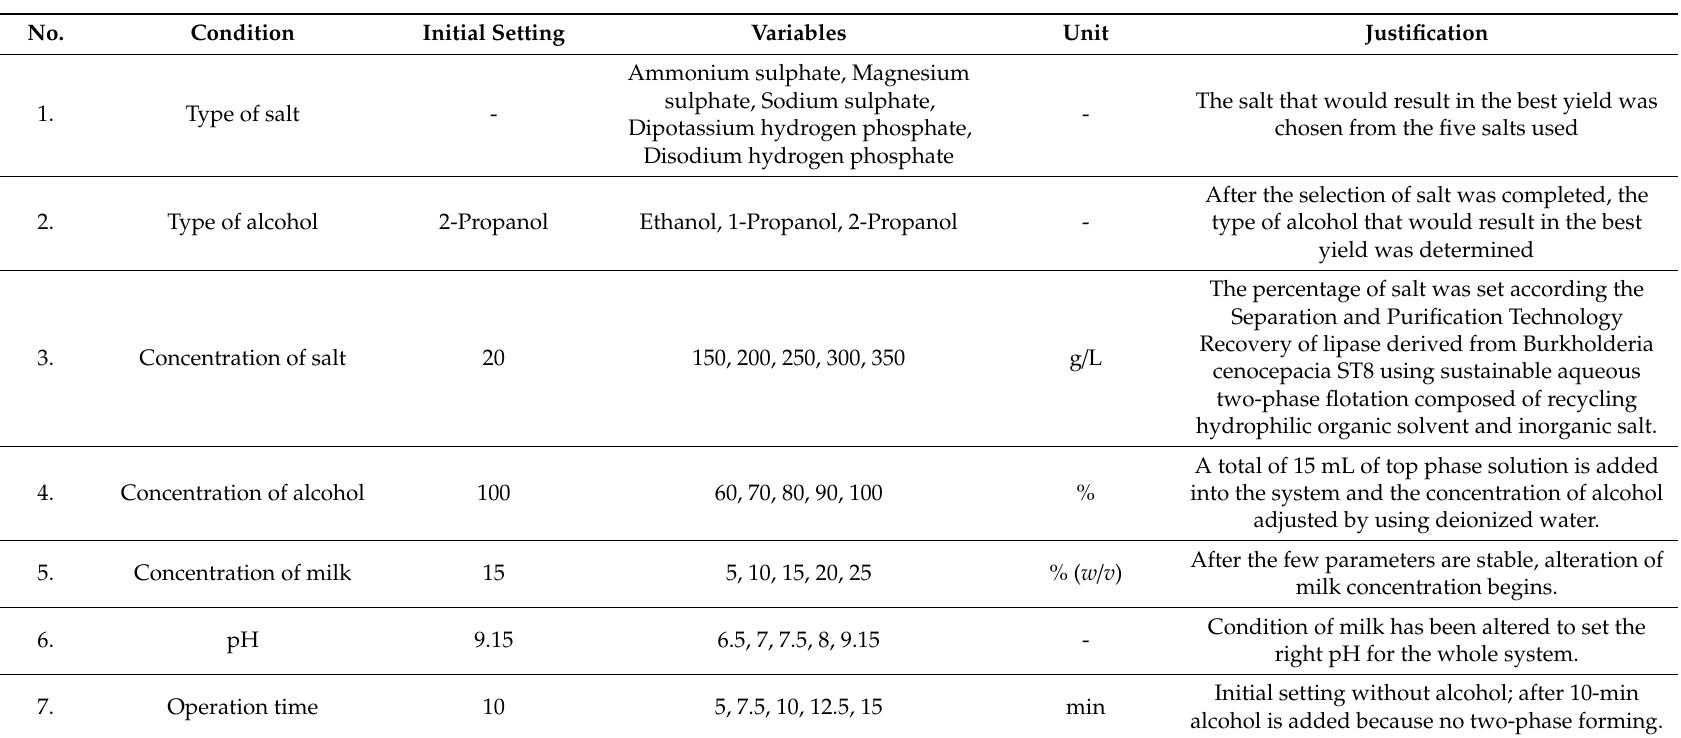
Table 1. Parameters and